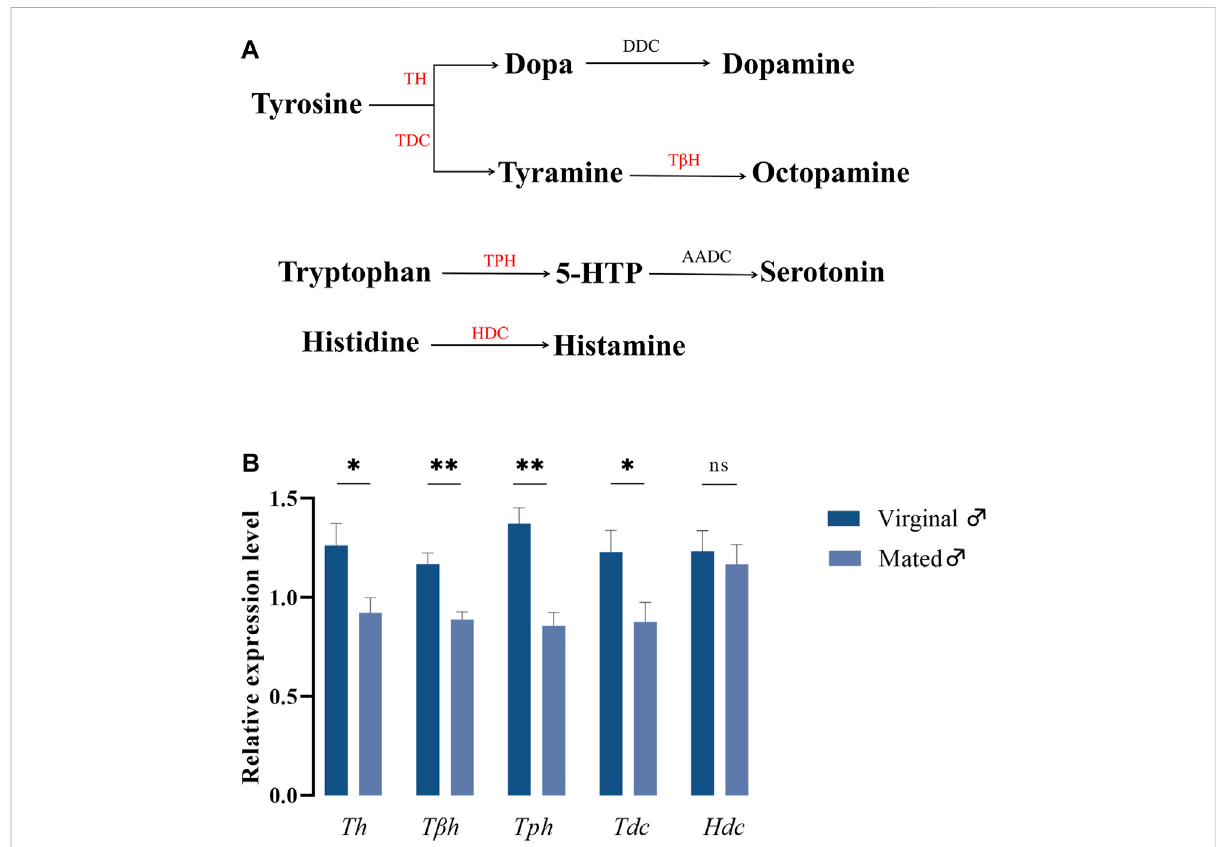
FIGURE 1 The roles of biogenic amines in B. dorsalis . (A) Synthesis pathways of biogenic amines in insects. The candidate enzymes were represented in red font. TH, tyrosine hydroxylase; DDC, dopa decarboxylase; TDC, tyrosine decarboxylase; T β H, tyrosine- β -hydroxylase; TPH, tryptophan hydroxylase;AADC,5-hydroxytryptophandecarboxylase;HDC,histidinedecarboxylase. (B) Thevariationsofgenescodingforbiosyntheticenzymes under different mating states. Values are the means (±SEs) of replicates. Statistical comparisons were based on Students ’ s t test. The level of signi fi cance for the results was set at * p < 0.05, ** p <